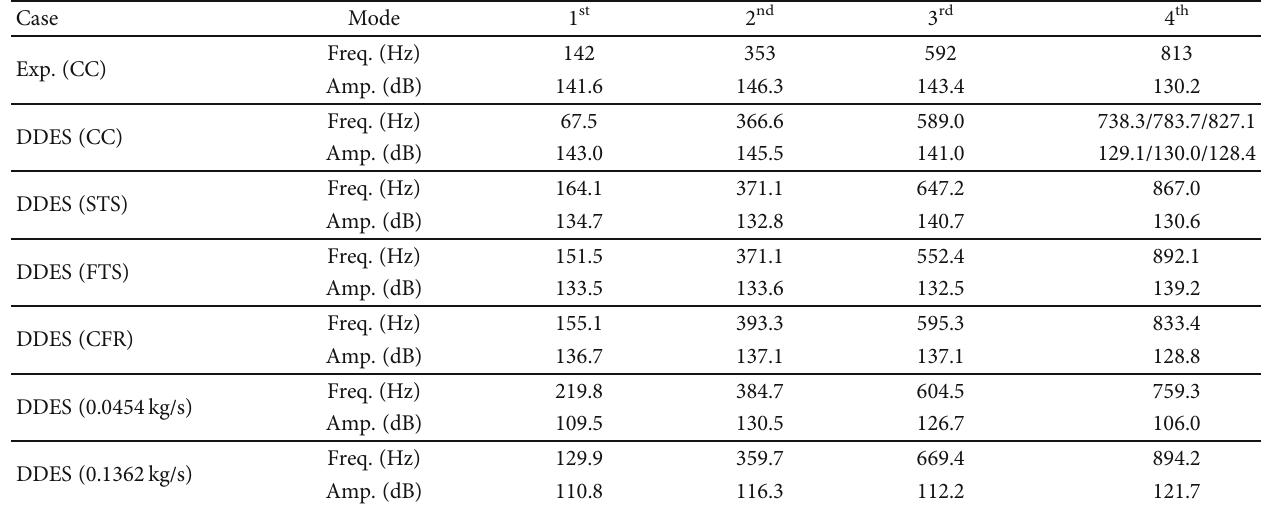
Table 1: Tone noise for all cases at x / L = 0 : 95